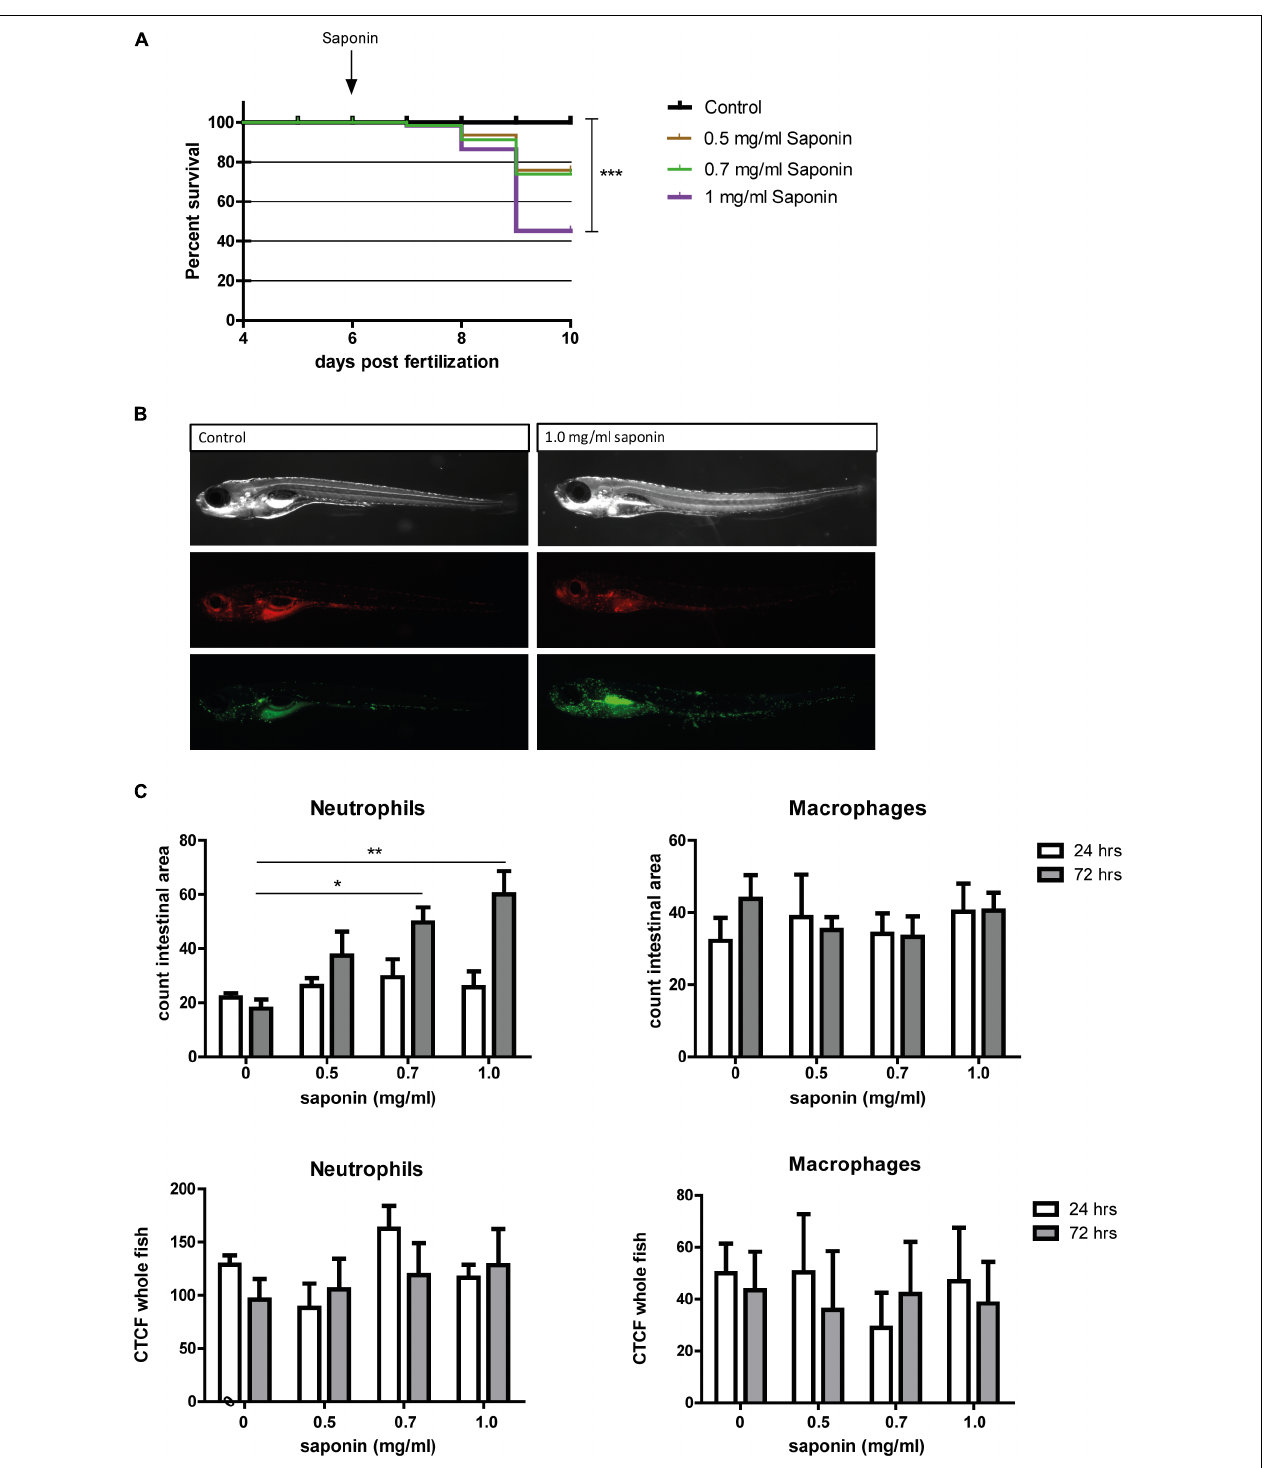
FIGURE 2 | Effect of saponin immersion on zebrafish larvae. (A) Percent survival of zebrafish exposed to control (E3), 0.5 mg/ml saponin, 0.7 mg/ml saponin and 1 mg/ml saponin from 6–9 dpf ( n = 40 fish/treatment) (Log-rank Mantel-Cox Test for Chi-square, ∗∗∗ p < 0.0005). (B) Representative pictures of the saponin-treated Tg(mpeg1:mCherry/mpx:eGFPi 114 ) fish displaying green neutrophils and red macrophages. (C) Quantification of neutrophils and macrophages in the intestinal area ( n = 6–11 fish/group) (one way ANOVA Kruskal-Wallis test with Dunn’s Multiple comparison Post-Test, mean ± SEM, ∗ p < 0.05 ∗∗ p < 0.01). Top: counted cells in intestinal area. Bottom: Corrected Total Cell Fluorescence (CTCF, measure for total fluorescent pixels in the whole fish). Two independent experiments were performed and data are combined.